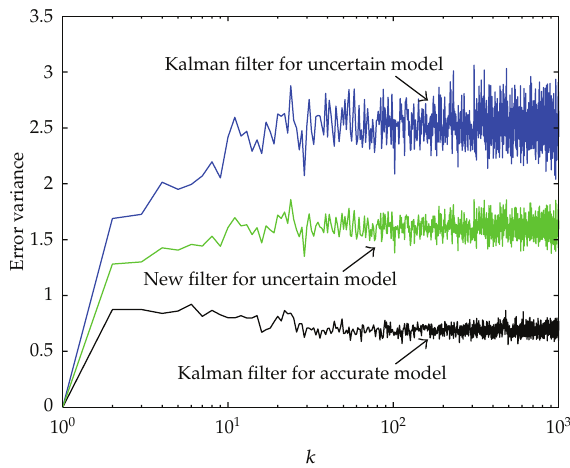
Figure 2: Comparison of the estimate variance x 2 k with di ff erent